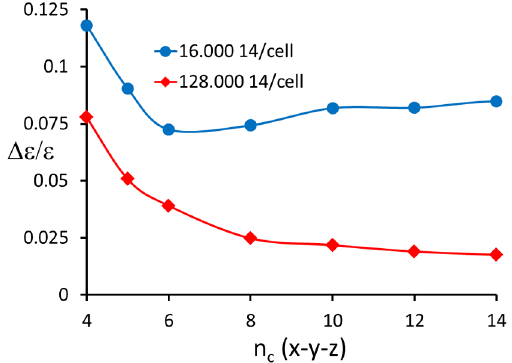
FIG. 9. Relative growth of ϵ 6 d for N ¼ 16 . 000 = 128 . 000 , as function of number of grid cells in x; y; z for periodic solenoid lattice of Fig.